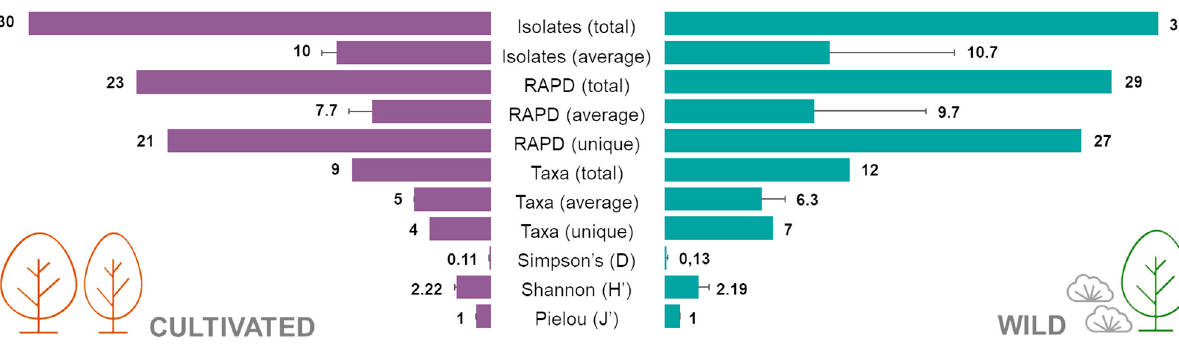
Figure 3. Number of isolates, RAPD profiles, taxa and diversity indexes (Simpson, Shannon and Pielou) of the endophytic bacterial isolates from cultivated and wild strawberry tree populations.